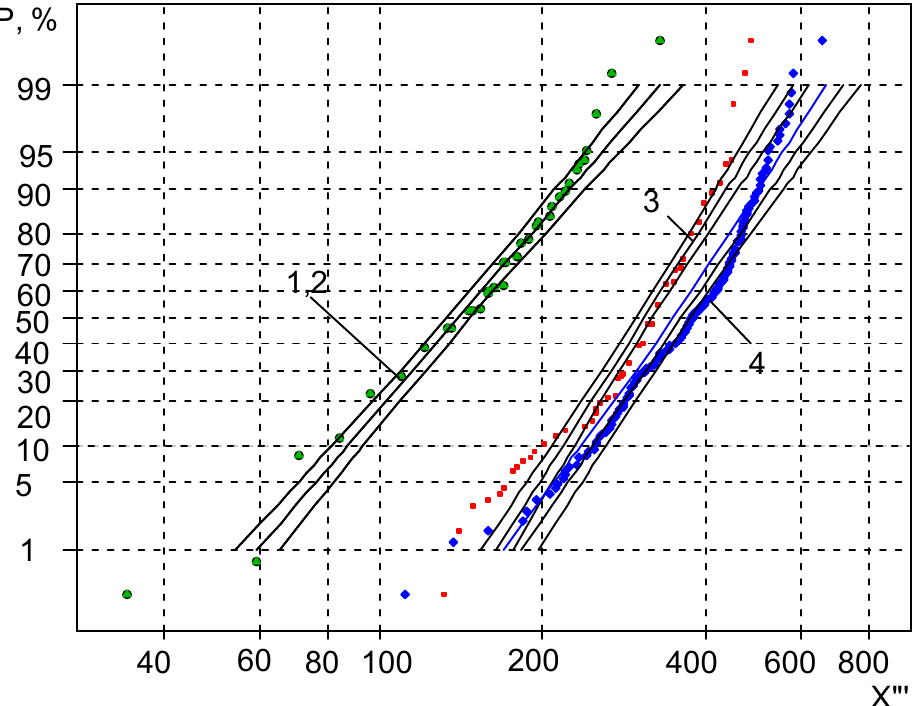
Figure 7. Statistical distribution curves for the mechanical properties of steel C45 with identified sensitivity thresholds N 0 and N k (1— σ y , 2— σ pr , 3— σ u , 4— S k